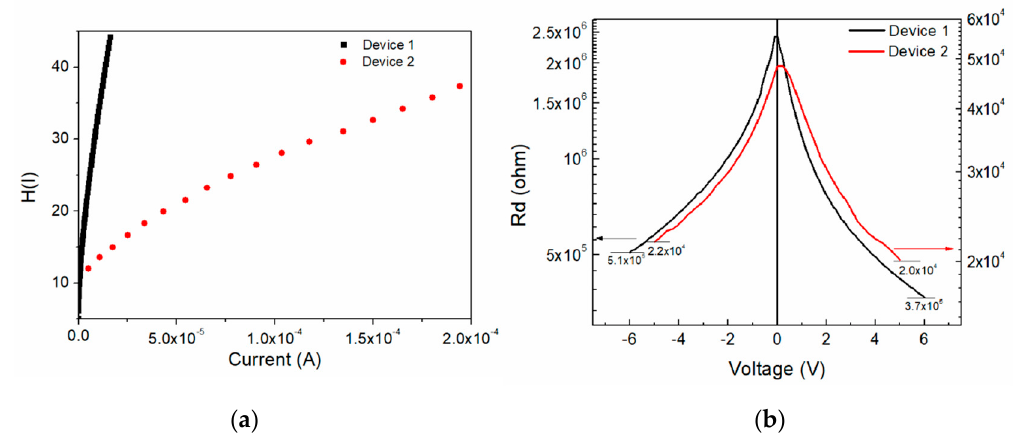
Figure 7. ( a ) Current-dependent H(I) and ( b ) voltage-dependent diode resistance of the devices.